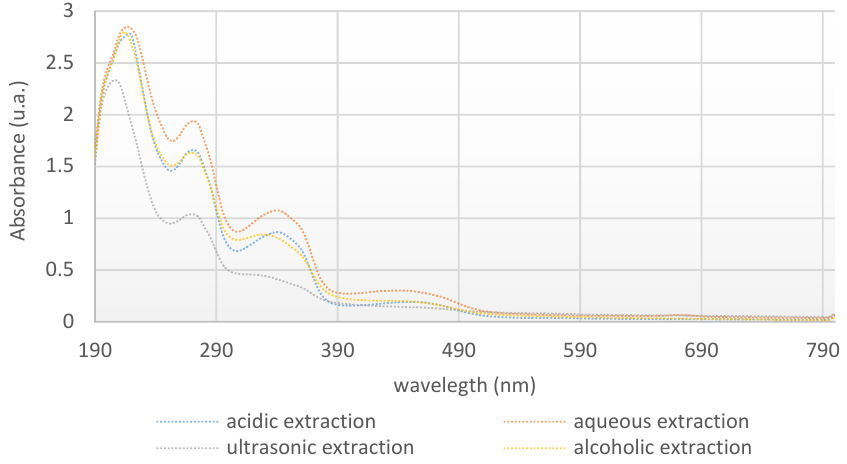
Figure 5. UV-Vis spectra of celandine extracts.